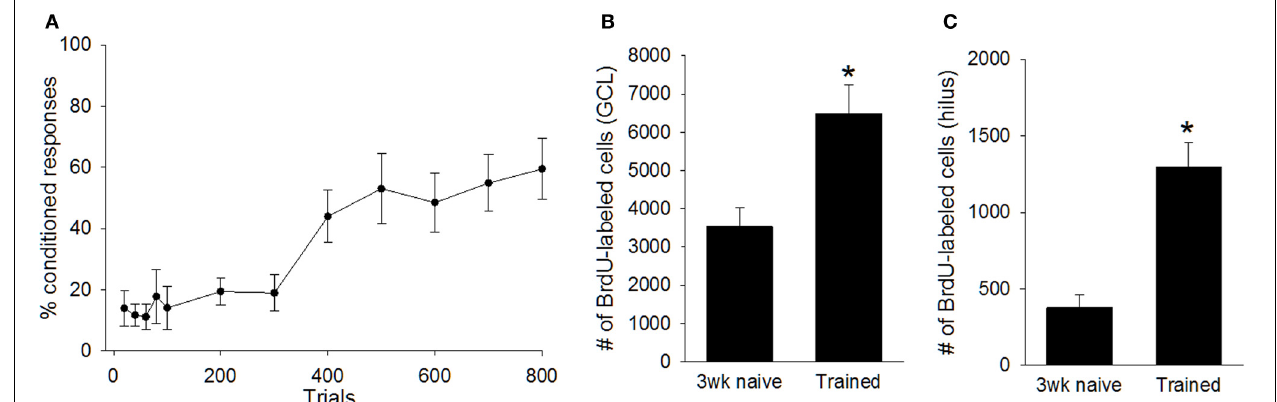
FIGURE 2 | (A) As a group, animals trained with trace eyeblink conditioning ( N = 9) acquired the conditioned response (B) Training prevented cell death in the dentate gyrus. Trained animals perfused three weeks after the BrdU